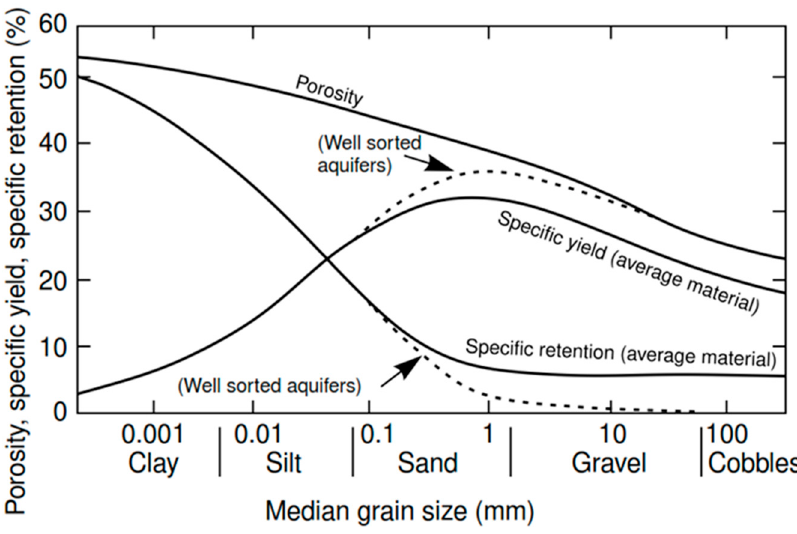
Figure 7. Relationship between median grain size and water-storage properties of alluvium.